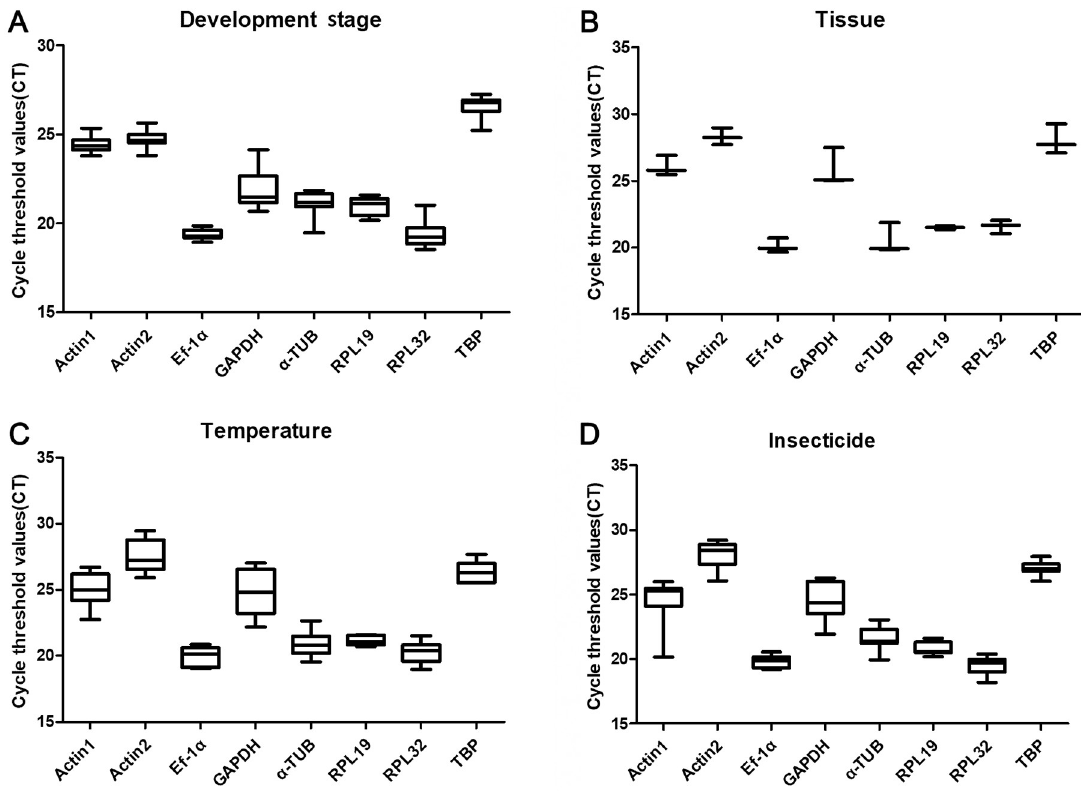
Fig 1. The cycle threshold (Ct) values of eight reference genes under different treatment conditions. The vertical bars represent the standard deviation.